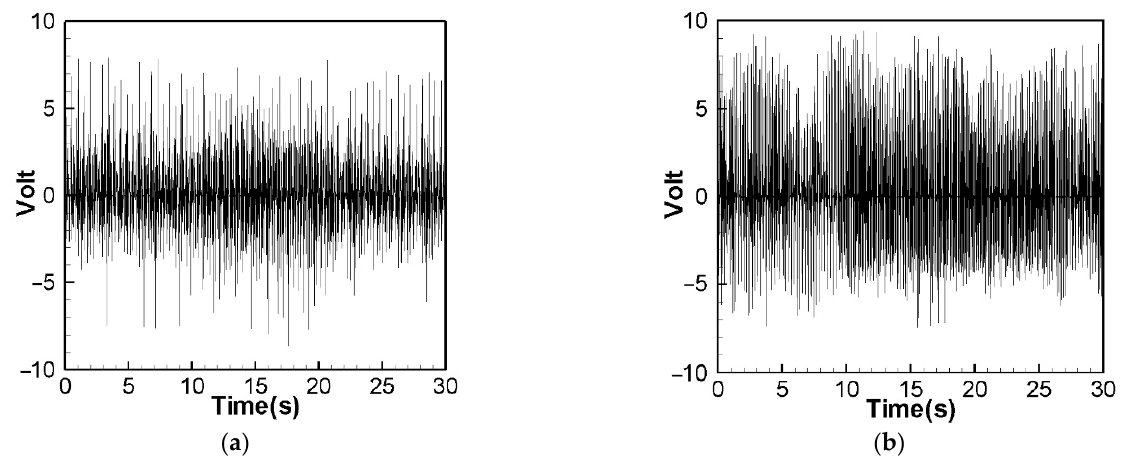
Figure 12. Experimental voltage output for nonlinear frequency excitation (elastic steel 7.5 cm). ( a ) 1st mode, ( b ) 2nd mode.